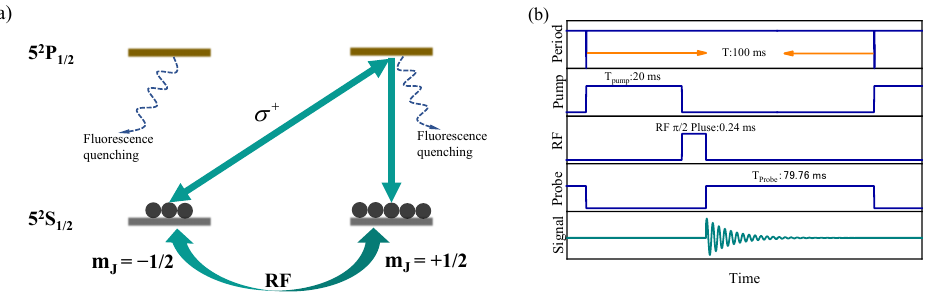
Figure 2. ( a ) Physics picture of spin polarization rubidium ensemble with proper N 2 gas pressure; ( b ) Time sequence diagram and typical time